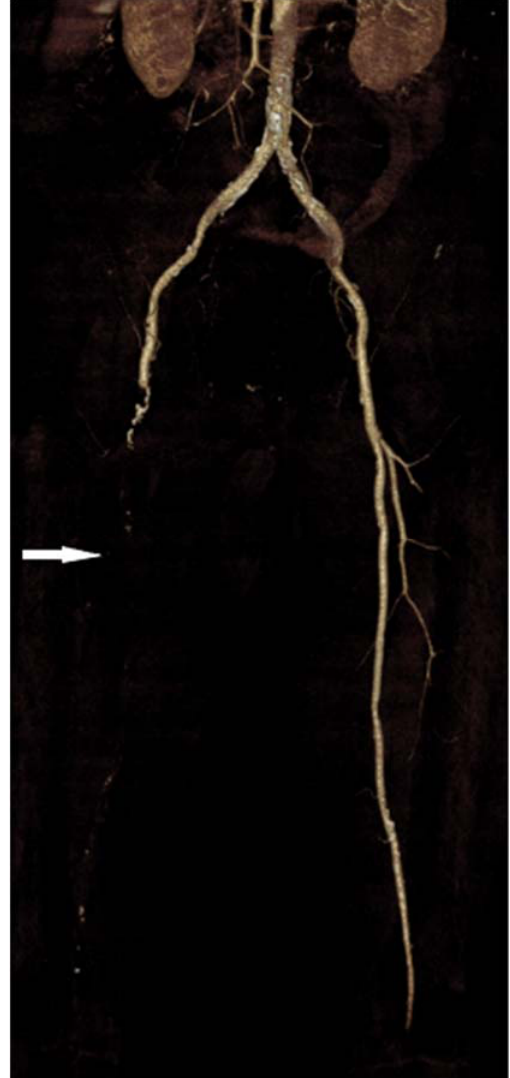
Figure 4. CTA volume ‐ rendered 3D reconstruction from a 66 ‐ year ‐ old male demonstrates long segment right superficial femoral artery occlusion (white arrow).